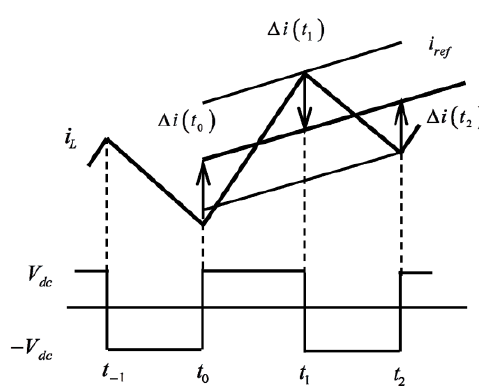
Figure 7. Proposed adaptive hysteresis current control.